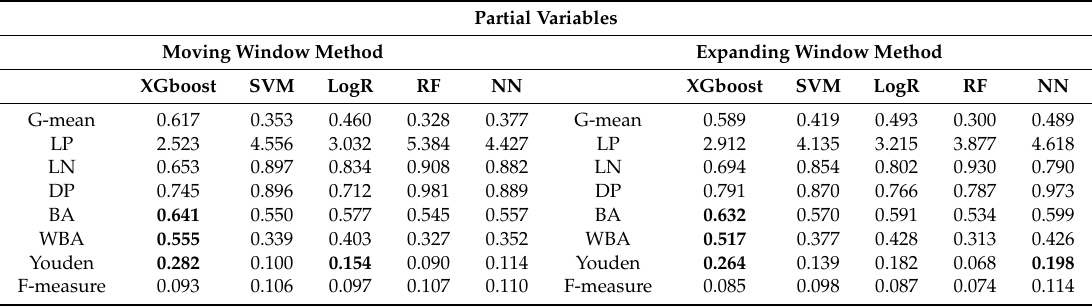
Table 6. Verification methods: Dependent variable concerns a US natural gas crisis (partial